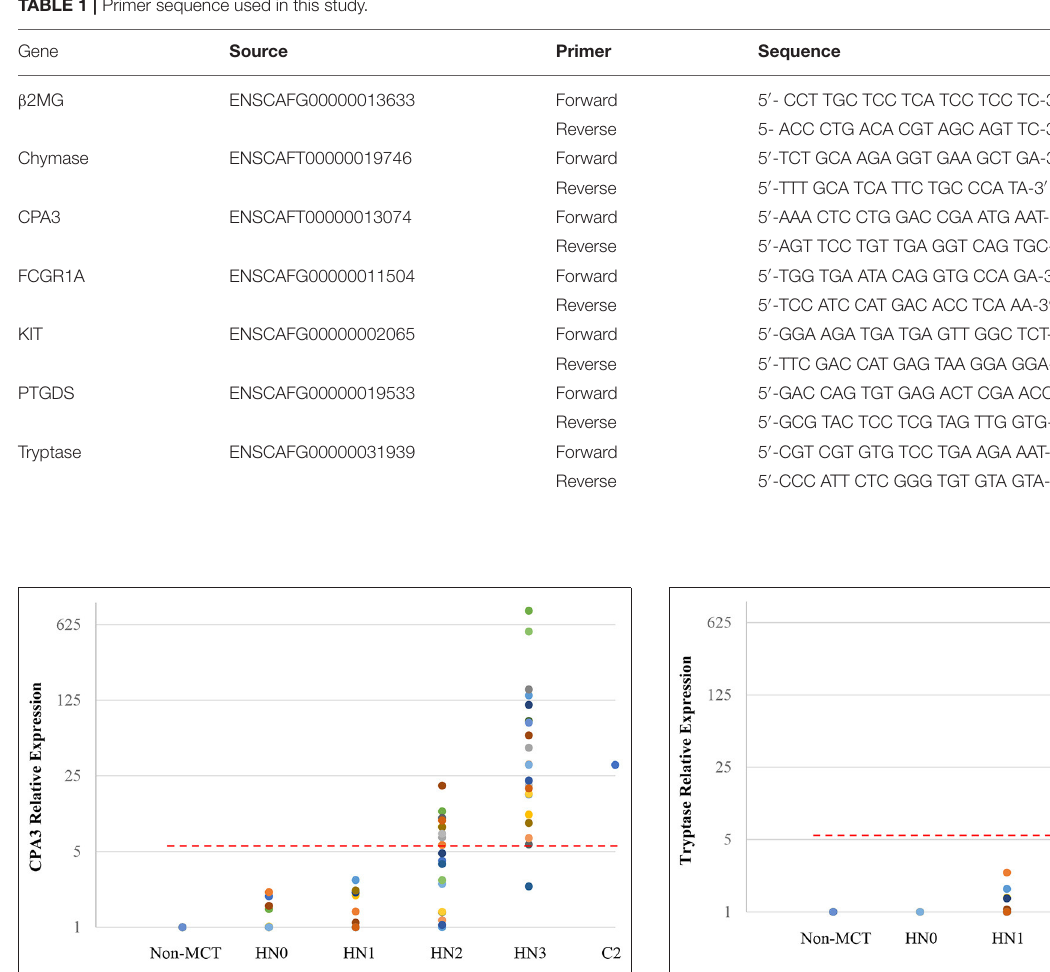
FIGURE 2 | Relative mRNA expression of Tryptase in each HN group determined by quantitative RT-PCR. Symbols showed mRNA levels in 17 LNs with HN0, 20 LNs with HN1, 20 LNs with HN2, and 21 LNs with HN3 compared with mixed HN0 LNs used as a calibrator. Red lines showed cut-off value at